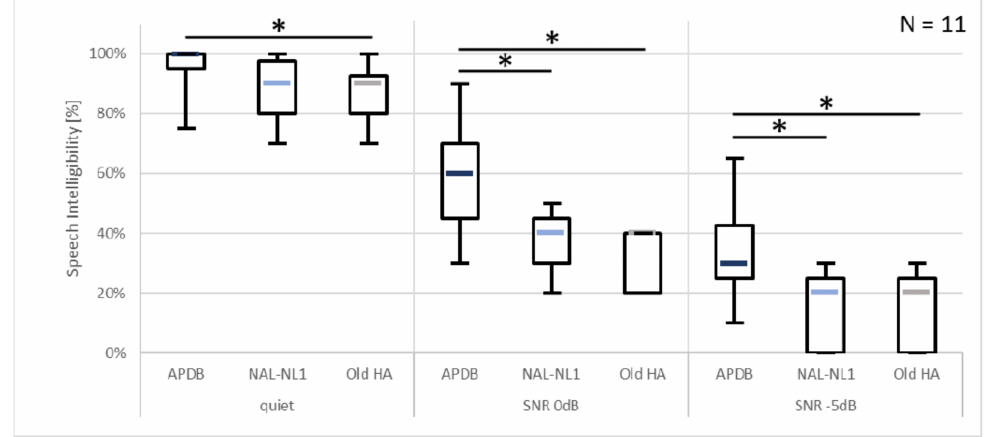
Figure 1. Speech intelligibility scores in % correct for the different noise conditions and different HA models and fitting approaches. Asterisks denote statistical